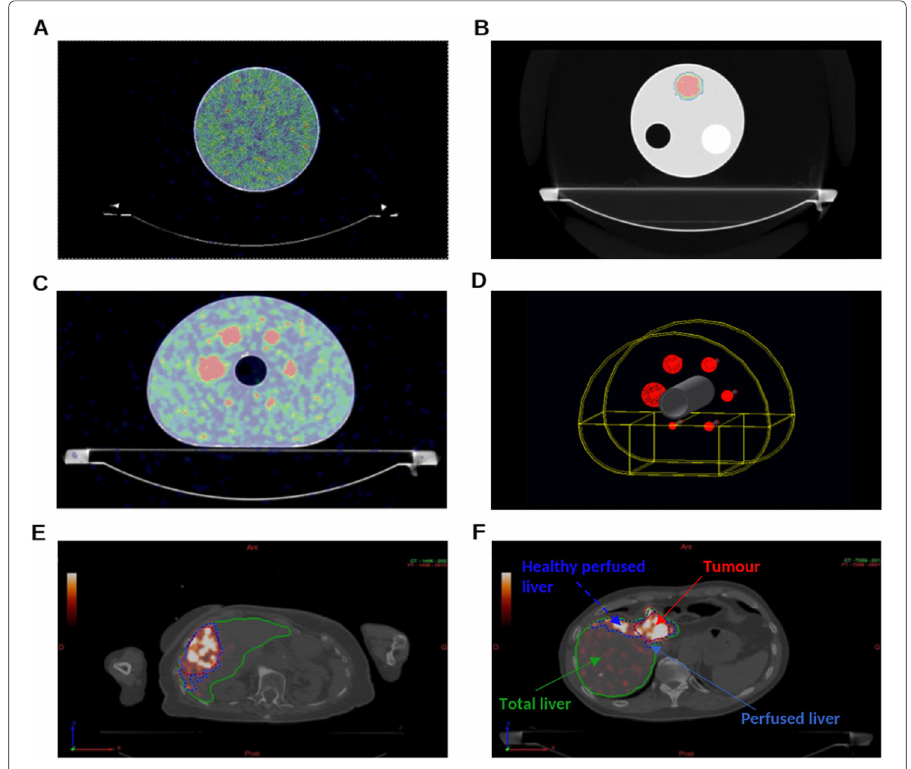
Fig. 1 Axial slices of PET/CT images of A Ph1, B Ph2 and C Ph3. D Geometry of Ph3 modelled in GATE. E , F Examples of segmentation of liver VOIs for patients #2 and #3,